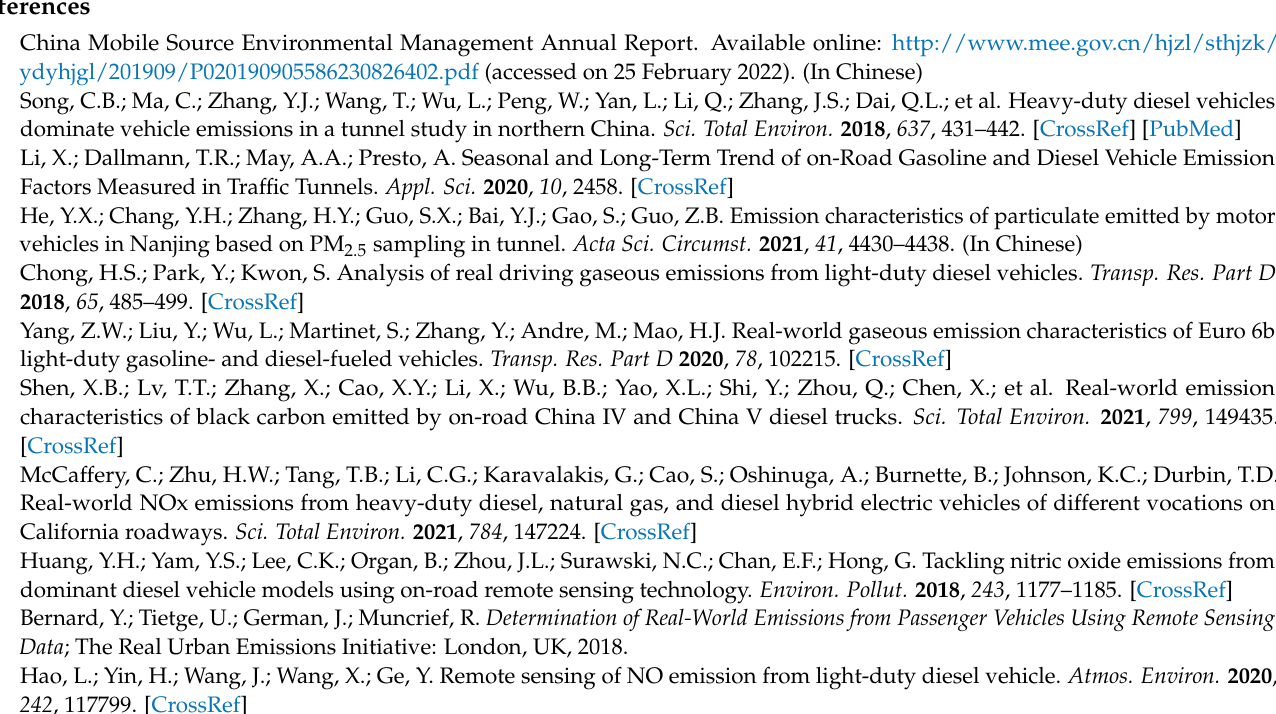
Figure S7: Comparison with other studies. Figure S8: The distribution map of uncertainty analysis. Table S1: Vehicle categories in this study corresponding with those in